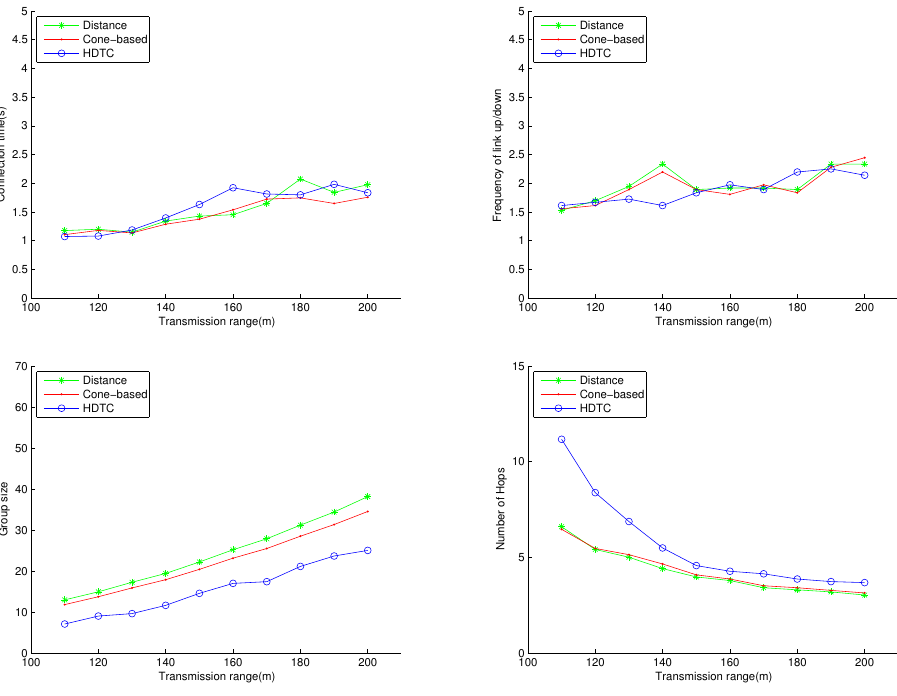
Figure 11. Scenario 1: The connection time, the frequency of the link up/down, the group size and the number of hops with varying the connection distance.